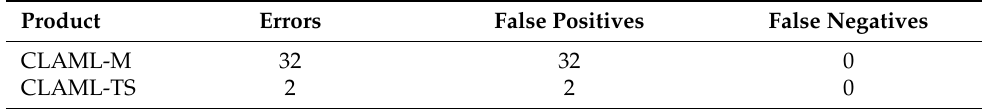
Table 9. Errors in cardinality batch with individualised